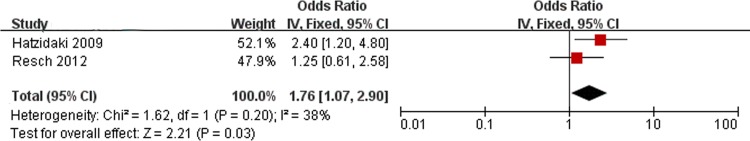
Fixed-effect model forest plot of the odds ratio of the association between apnea and PVL.The pooled OR of apnea is presented as a solid diamond at the bottom of the forest plot, the width of which represents the 95% CI.